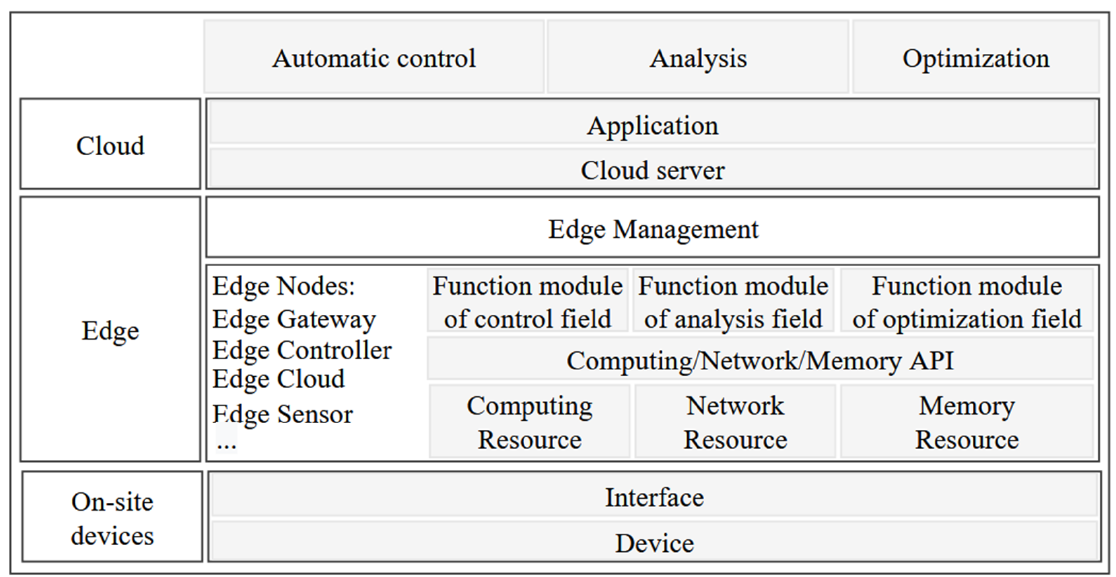
Figure 3. The architecture of edge image processing module.